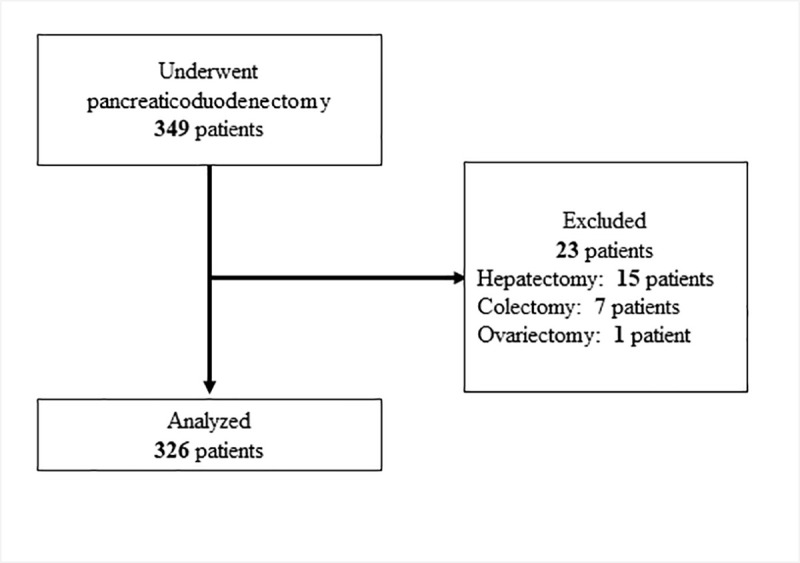
Flow chart of study enrollment.